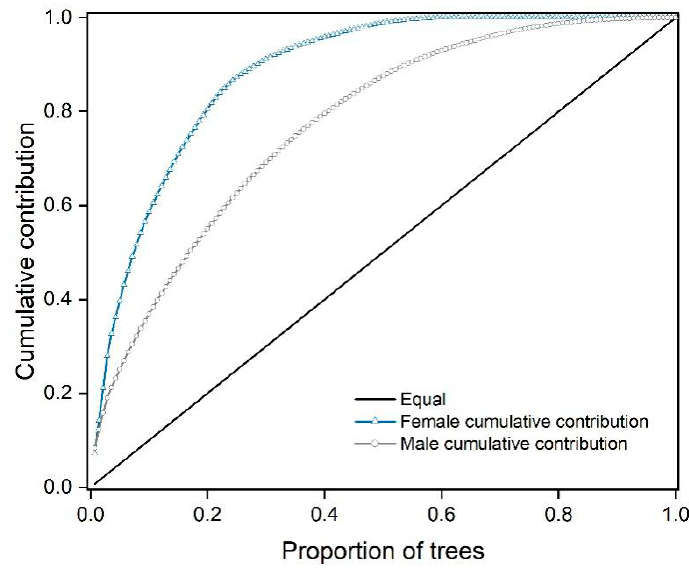
Figure 1. Parental–balance curve of female and male strobilus production in the CSO.